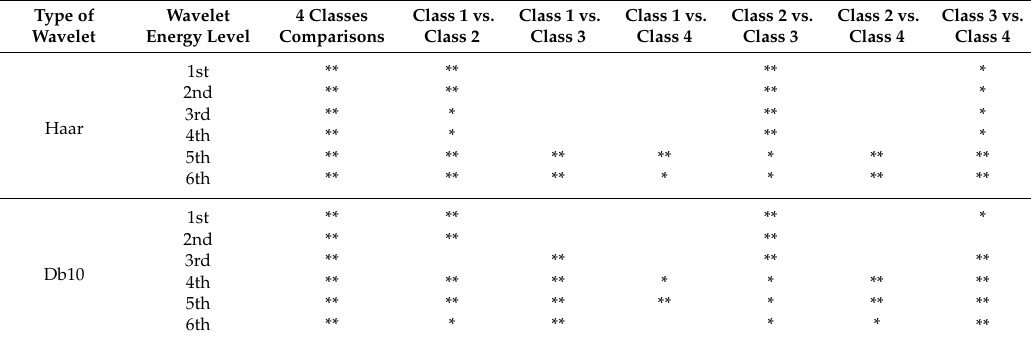
Table 4. Table presenting p -value results of the statistical comparisons regarding 4 classes and